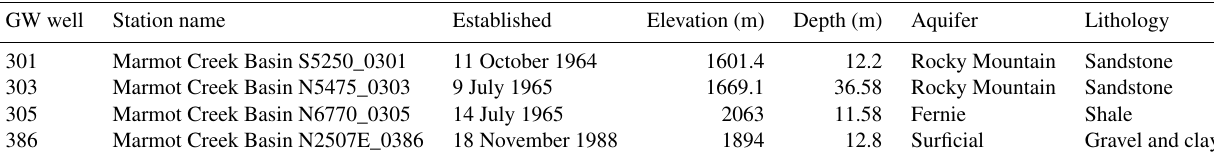
Table 6. Active groundwater wells (GWs) at the Marmot Creek Research Basin. GW